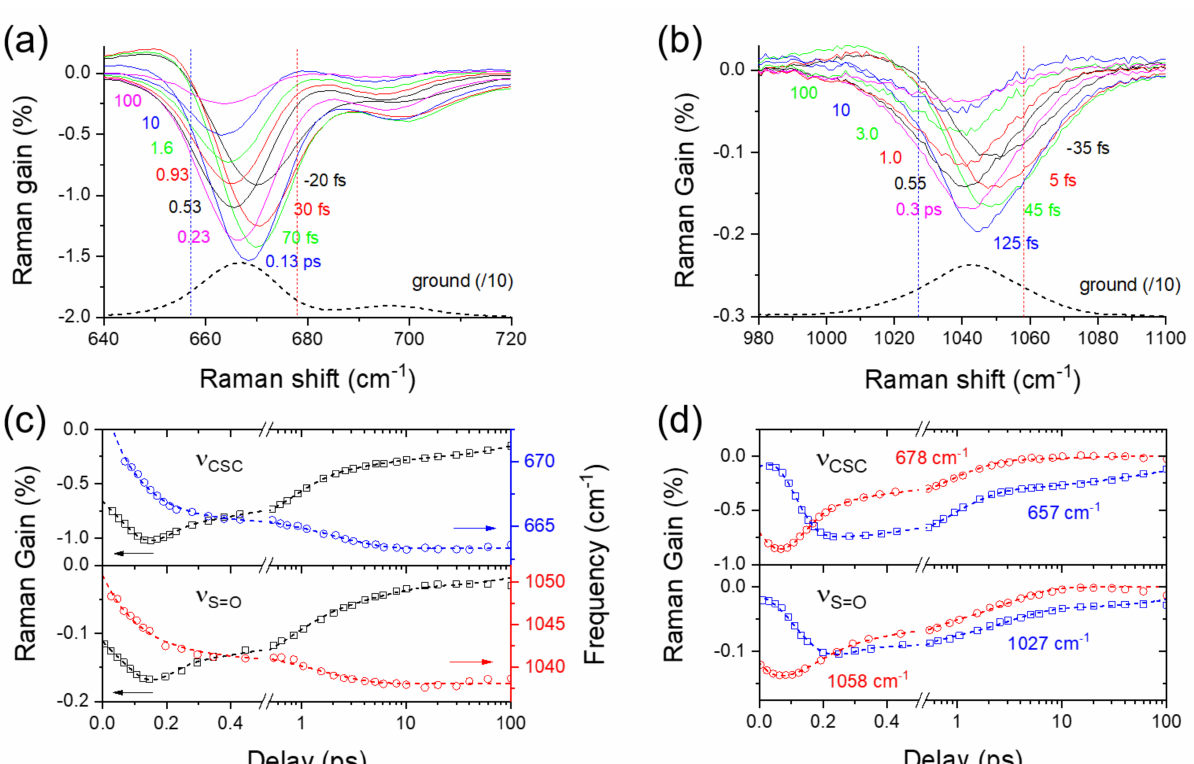
Figure 6. Transient spectral changes in the ( a ) ν CSC and ( b ) ν S=O of solvent DMSO obtained from FSRS measurements of curcumin with 403 nm excitation. The ground-state spectra of DMSO were also compared. ( c ) The population dynamics and frequency shifts of ν CSC and ν S=O modes of solvent DMSO, ( d ) the population dynamics of the sub-bands of ν CSC and ν S=O modes of solvent DMSO. Open symbols represent the experimental data and dotted lines represent the fit